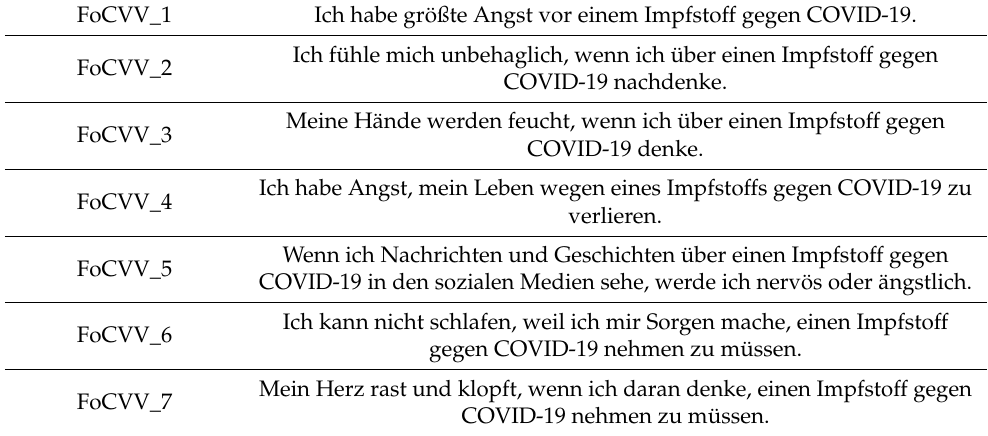
Table A2. Fear of Coronavirus Vaccination Scale (FoCVVS) in the German language. Einstellung zum COVID-19-Impfstoff. Markieren Sie Ihre Antworten auf der Skala von 1 bis 5: 1 = Ich stimme überhaupt nicht zu; 2 = Ich stimme nicht zu; 3 = Neutral; 4= Ich stimme zu; 5 = Ich stimme voll